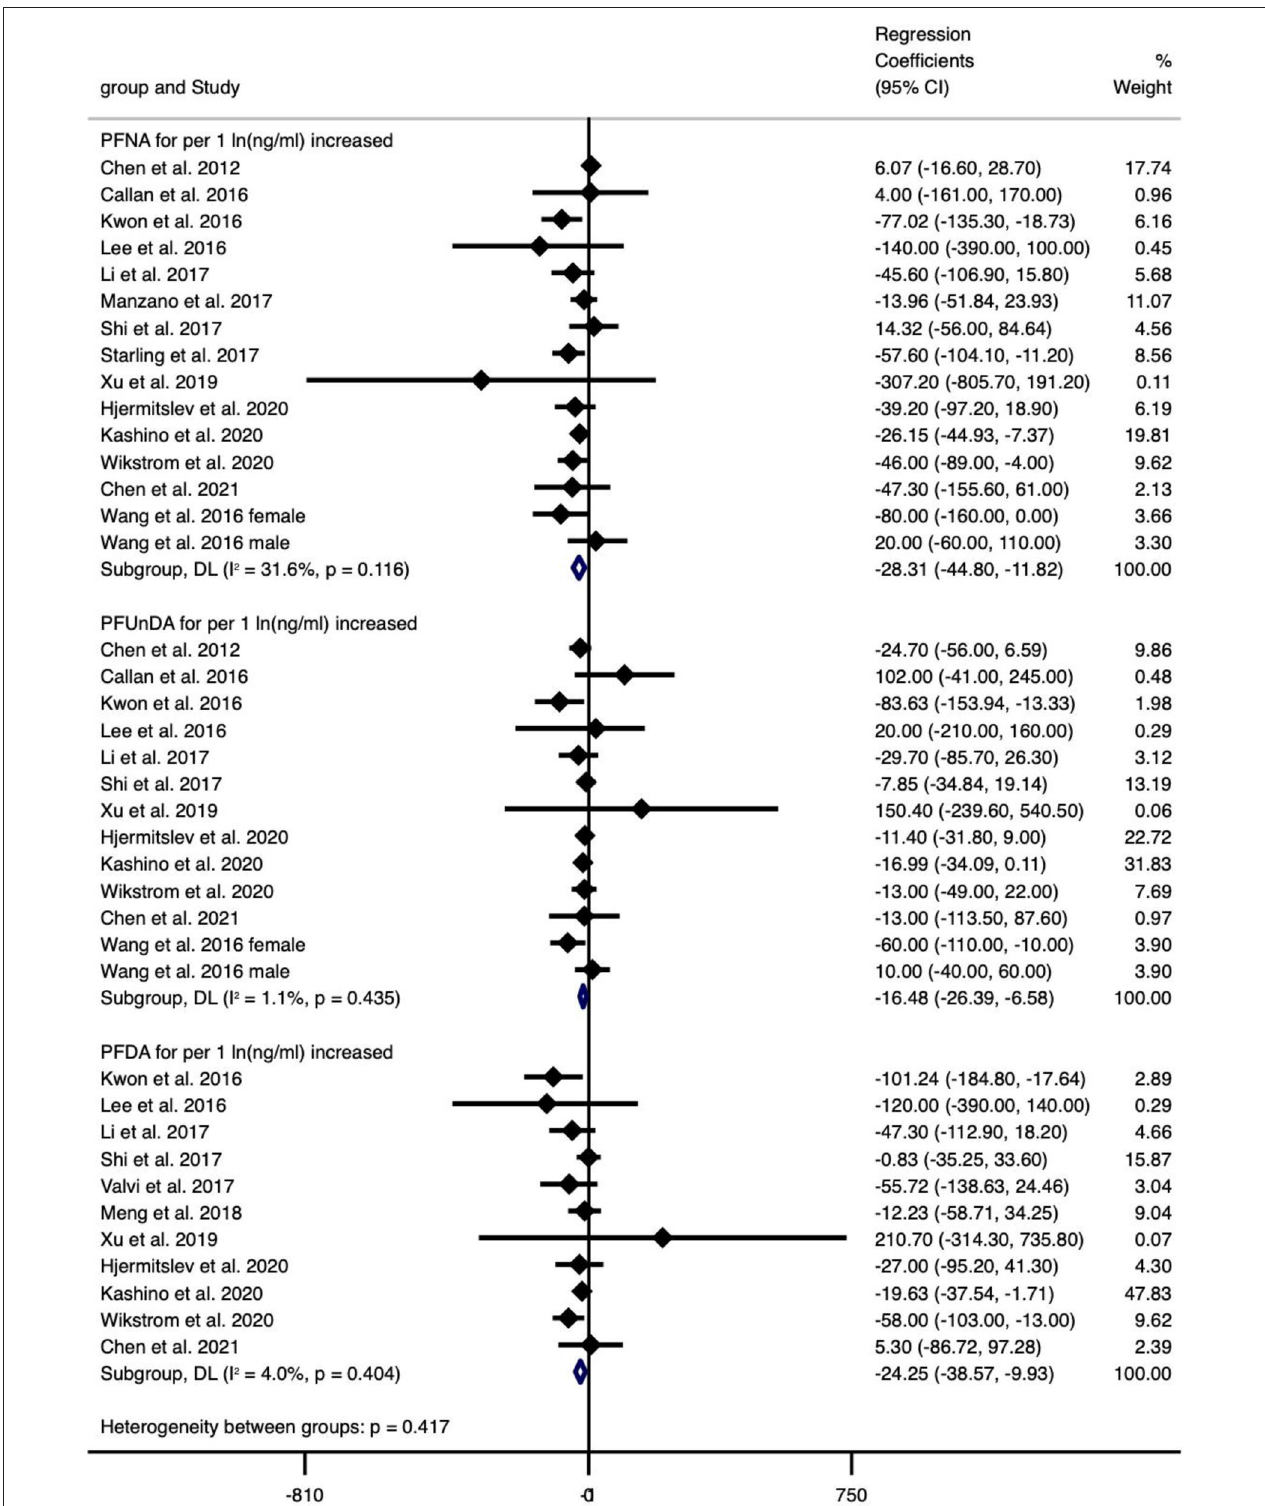
FIGURE 3 | Meta-analysis of the associations of PFNS, PFUnDA and PFDA with birth weight (g) for per 1 ln(ng/ml) increment of exposure.